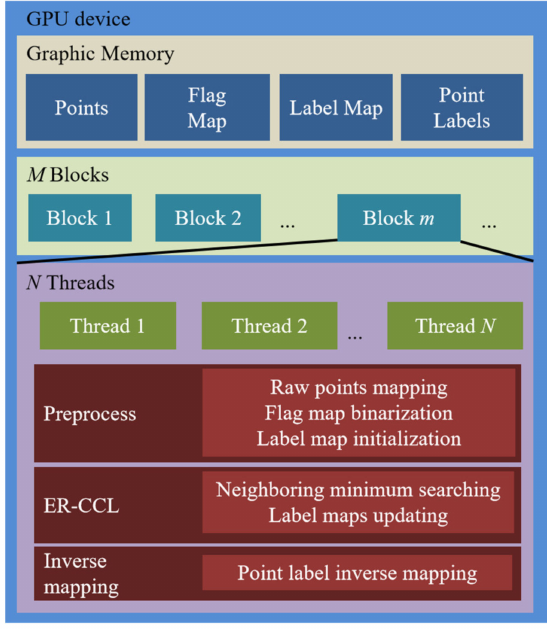
Figure 4. Memory and thread allocation in GPU device.